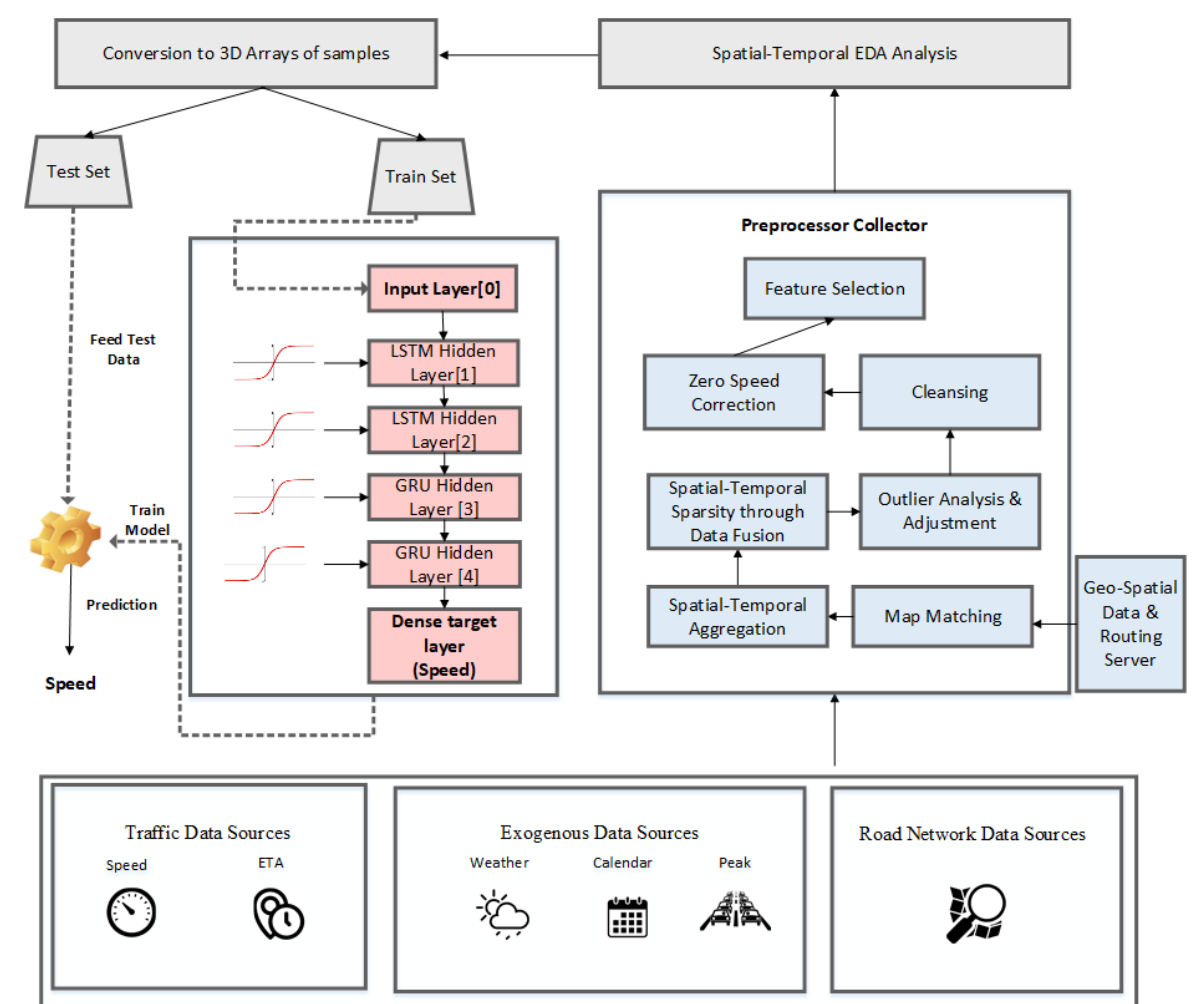
Figure 1. Urban traffic speed prediction based on hybrid LSTM–GRU